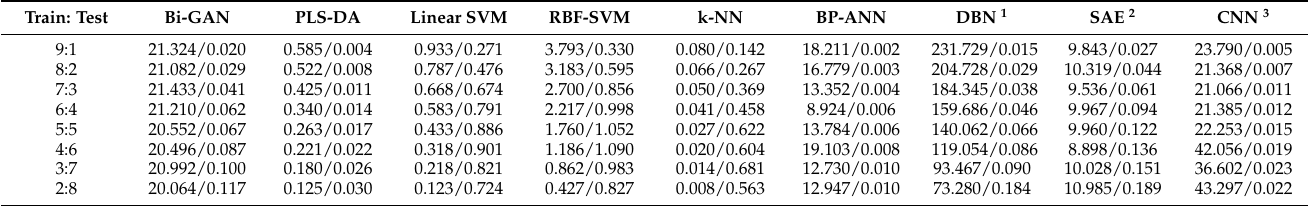
Table 4. Training and inferencing time of each algorithm (in second, training time/inferring